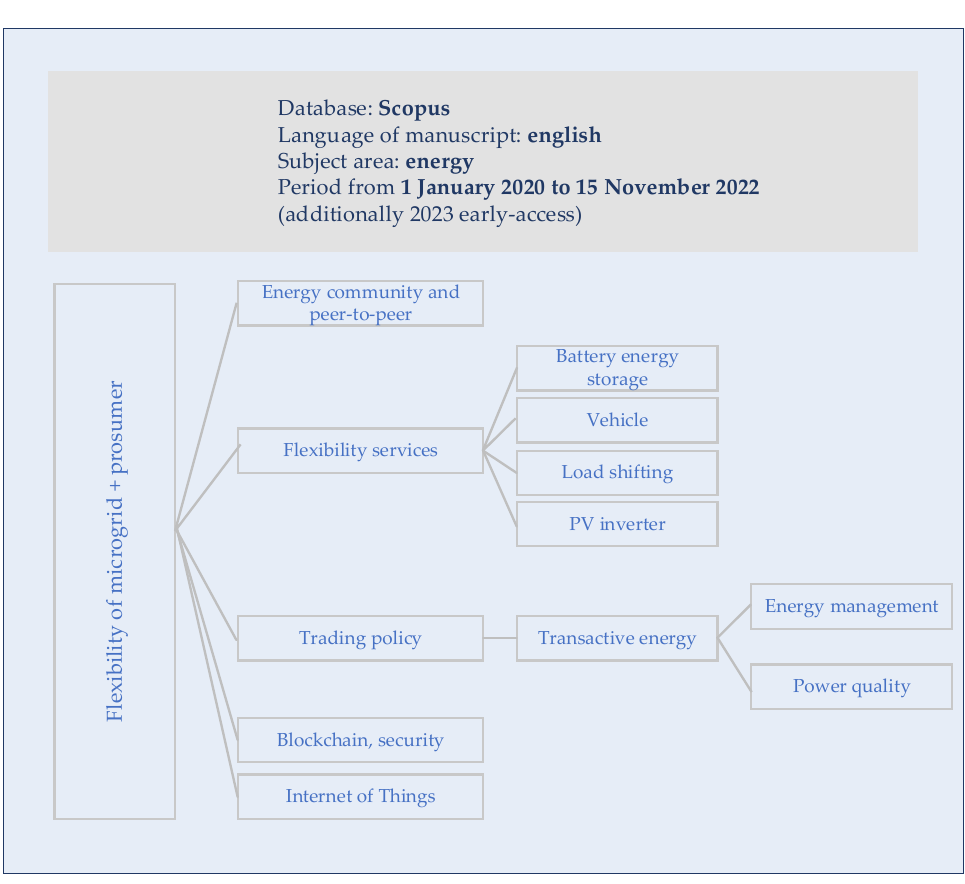
Figure 1. Methodology of analysis of literature resources in terms of selected development directions in the area of electricity grid flexibility, including the contribution of photovoltaic installations.